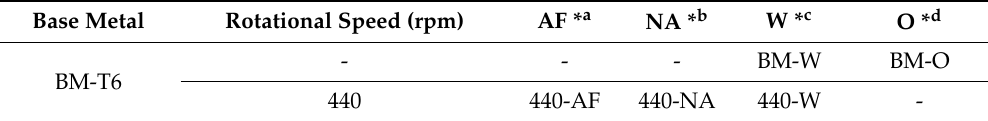
Table 1. Experimental conditions and specimen